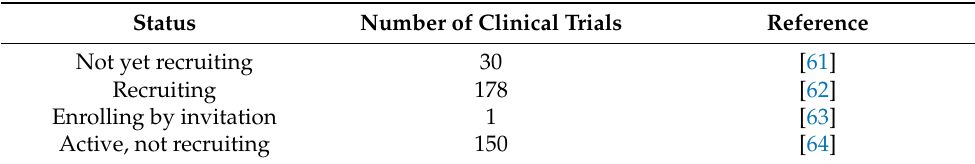
Table 2. The number and status of all clinical trials currently evaluating vincristine on cancer patients (June